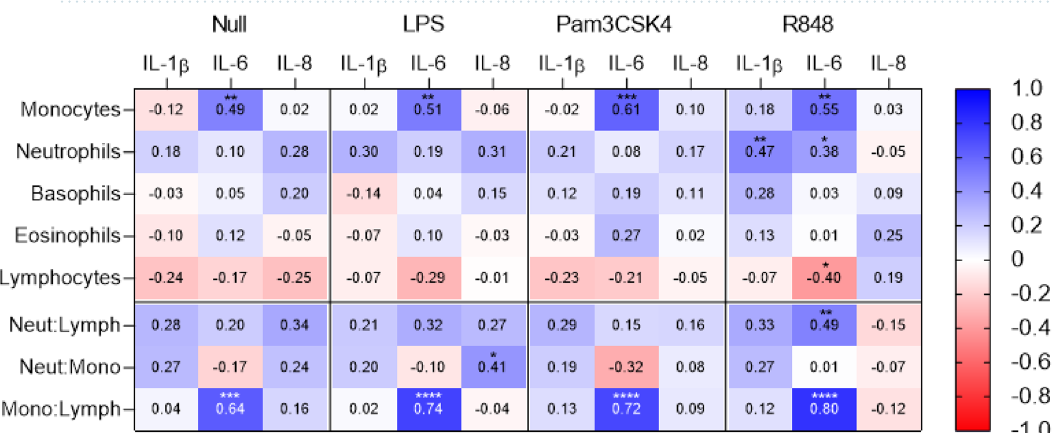
Figure 6. Correlations between cytokine and chemokine responses and absolute cell counts . Pearson’s correlation coefficients, represented as a heatmap, calculated between IL-1β, IL-6 and IL-8 levels in response to null, 2 µg/mL of LPS, 1 µg/mL of Pam3CSK4 and 0.2 µg/mL of R848, and absolute counts data for monocytes, neutrophils, eosinophils, basophils, lymphocytes and the cell ratios of neutrophils to lymphocytes, neutrophils to monocytes and monocytes to lymphocytes, gathered from the same ten animals at the same timepoints. All protein response and absolute cell counts data was generated from the same ten animals across the same three timepoints. Results were graphed using Prism software (v9.1) (www. graph pad.